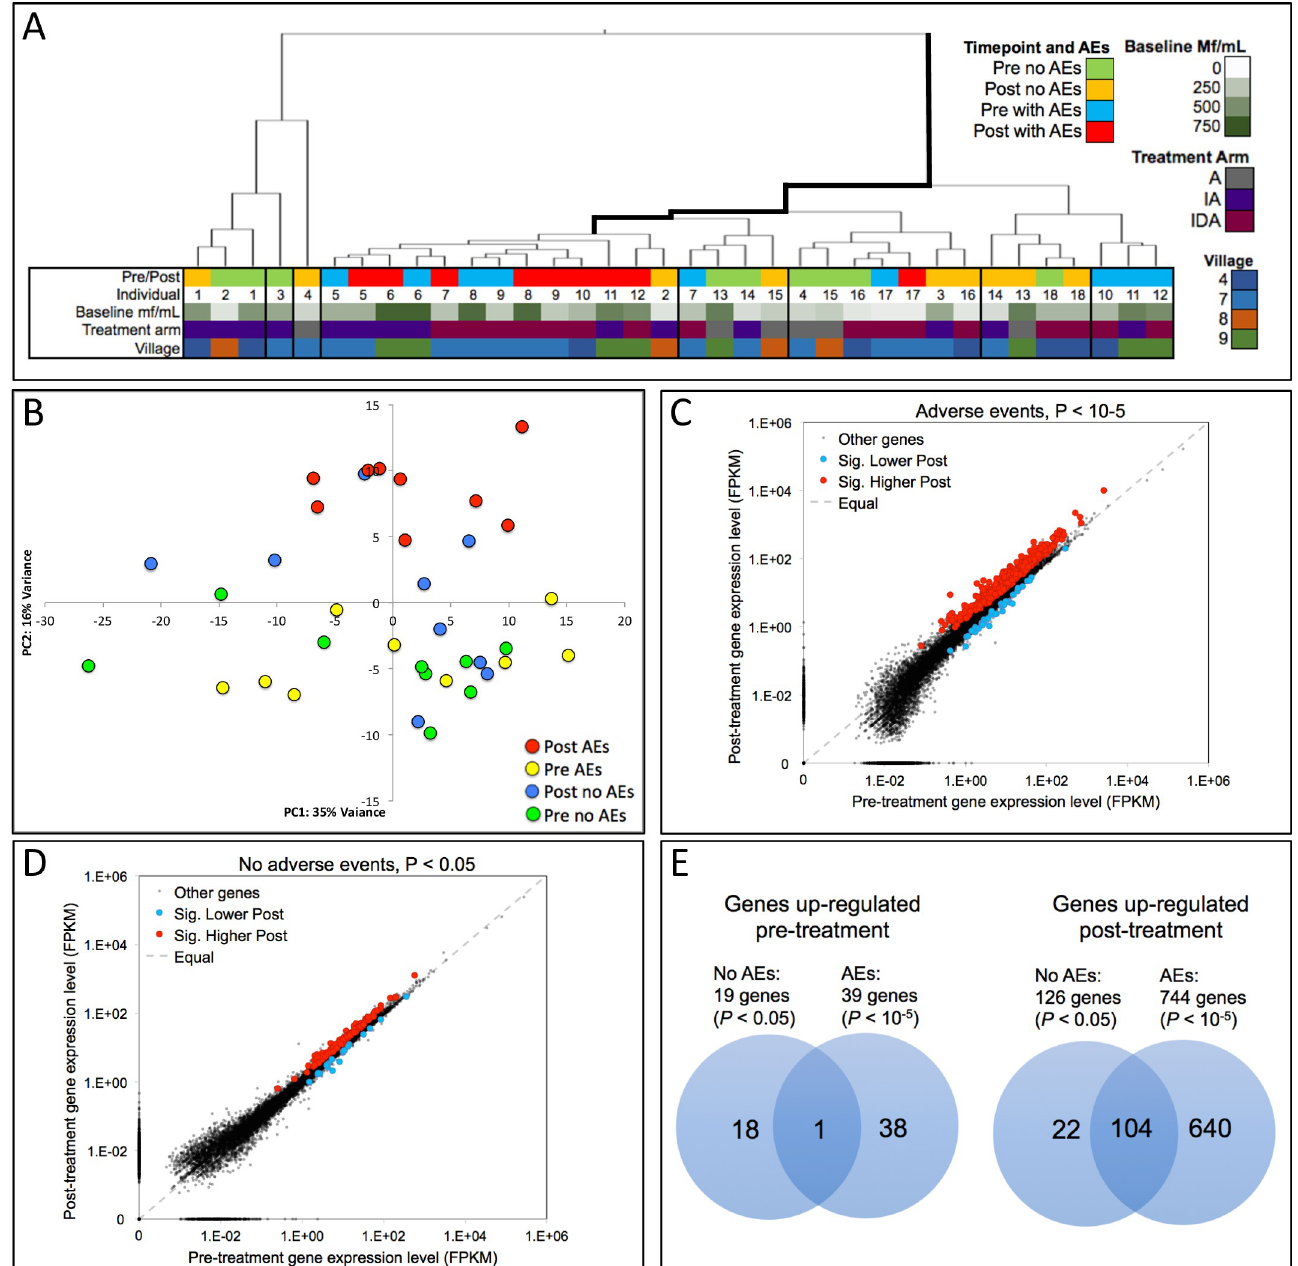
Fig 4. Overall expression patterns and enrichment pre- and post-treatment (n = 9 with moderate adverse events (AEs), n = 9 with no AEs). Fig 4A: Sample clustering (Euclidean distance) based on gene expression profiles across all genes. Post-treatment AEs (red) samples are significantly overrepresented in the fourth group (bolded, P < 0.0001, binomial distribution). Treatment arms; A: albendazole (ALB), IA: ivermectin (IVM) and ALB, IDA: IVM, diethylcarbamazine and ALB. B: Principal component analysis of paired samples. Post-treatment AEs samples (red) are significantly different from their pre-treatment controls (yellow) ( P = 0.005 by PERMANOVA). No other differences between the four groups are significant. C/D: Expression plots comparing pre- and post-treatment gene expression in individuals with moderate AEs (C) and individuals with no AEs (D). Red dots represent genes significantly upregulated post-treatment, and blue dots are genes significantly upregulated pre-treatment ( P < 10 − 5 for the AE group (C), and P < 0.05 for the no AE group (D) from DESeq2). E: Overlap between the genes upregulated pre- and post-treatment between the two AE groups.